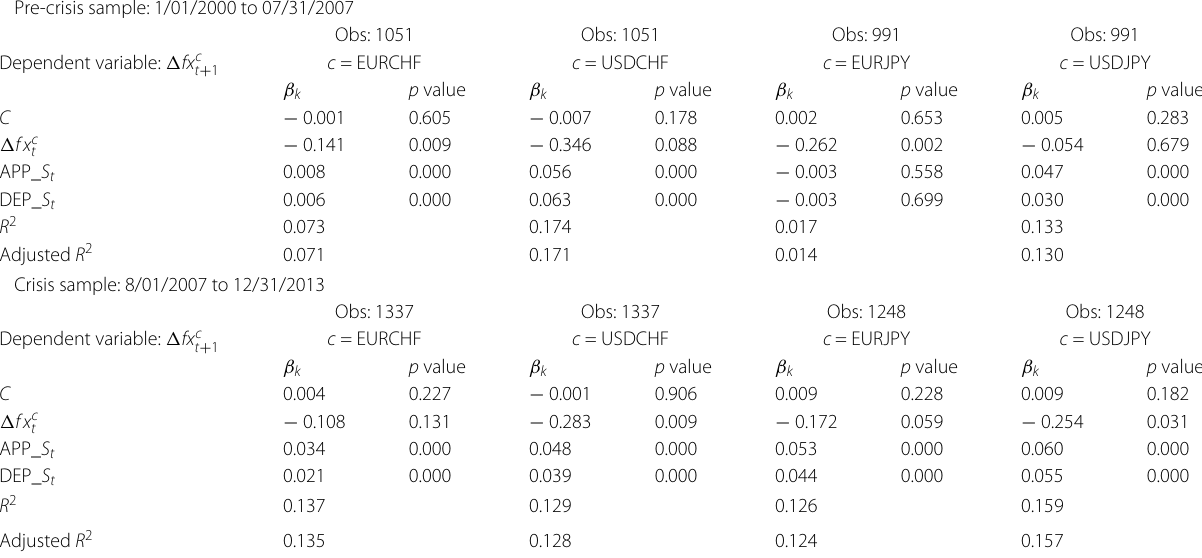
Pre-crisis sample: 1/01/2000 to